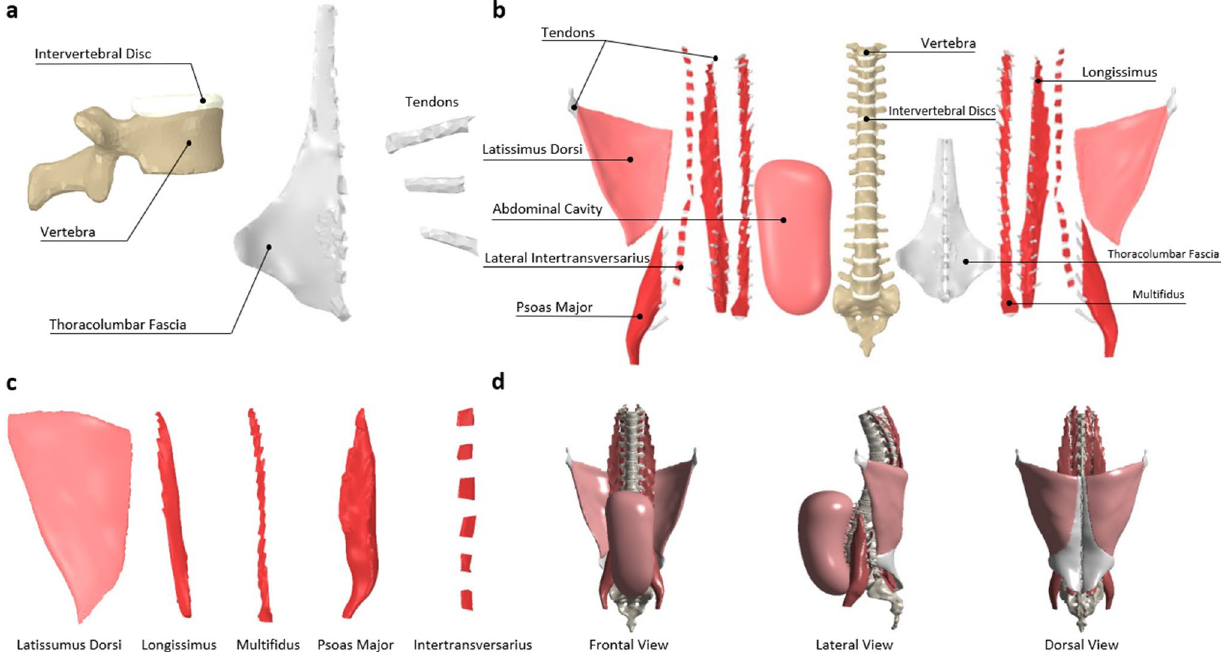
Figure 1. Finite element model of the spine produced via ANSYS Static Structural (v.19.1, Canonsburg, Pennsylvania, United States, https ://www.ansys .com/). ( a ) Vertebral bodies, intervertebral discs, thoracolumbar fascia, and tendons modelled as volumetric deformable bodies. ( b ) Exploded view of all parts considered in the spine model. ( c ) Major torso muscles modelled as pressurized structures. ( d ) Frontal, lateral, and dorsal views of the full spine finite element